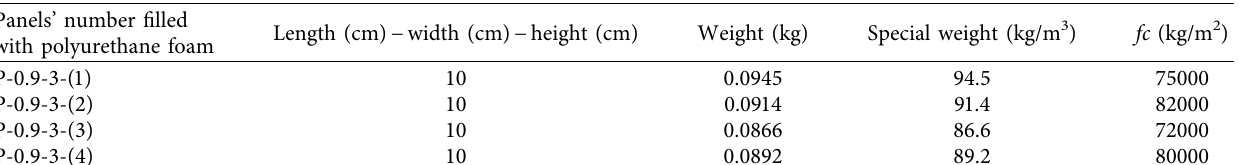
Table 4: Special weight, dimension specification, and compression strength table (fire-resistance polyurethane foam samples 10cm ∗ 10cm ∗